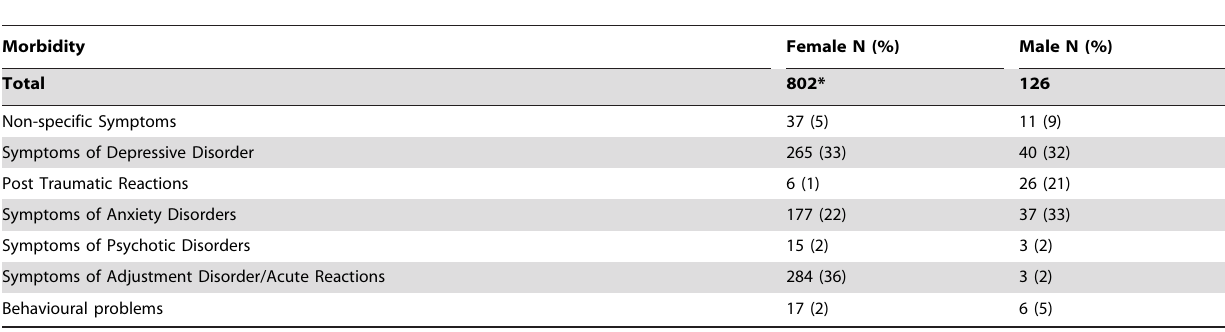
Table 5. Mental health morbidity among new mental health consultations stratified by gender, Timurgara district hospital, Pakistan